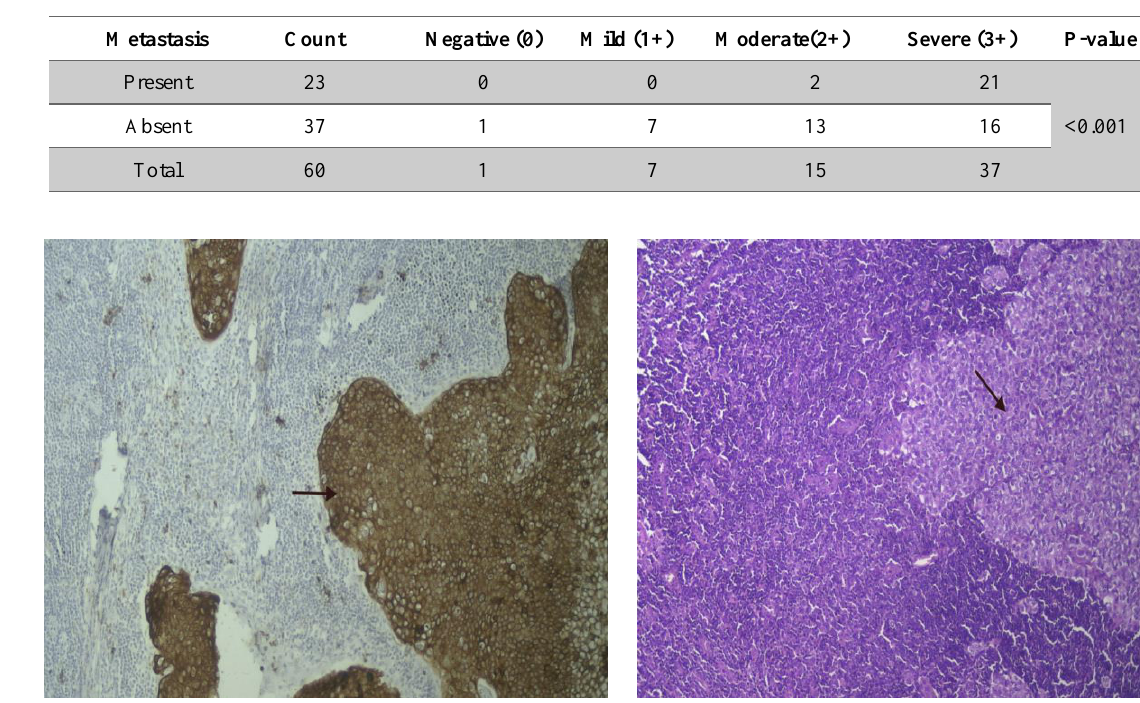
Table 4. The Relationship between SI score and metastases